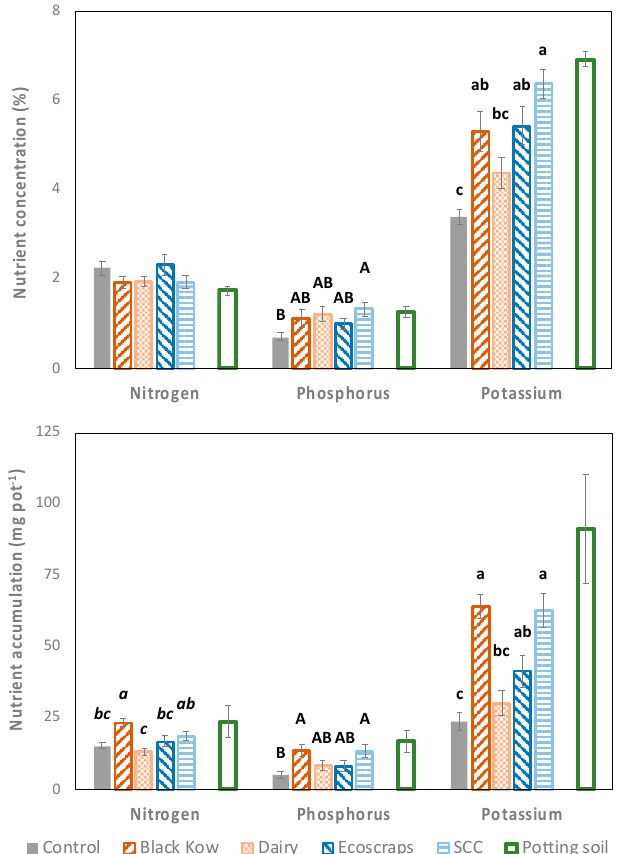
Figure 4. Mean ( ± standard errors) of nitrogen, phosphorus, and potassium concentration ( top ) and accumulation ( bottom ) with different soil amendments in the Lake soil. Different letters represent statistically different means among amendments based on Tukey’s HSD ( α ≤ 0.05). The potting soil was not included in the analysis.